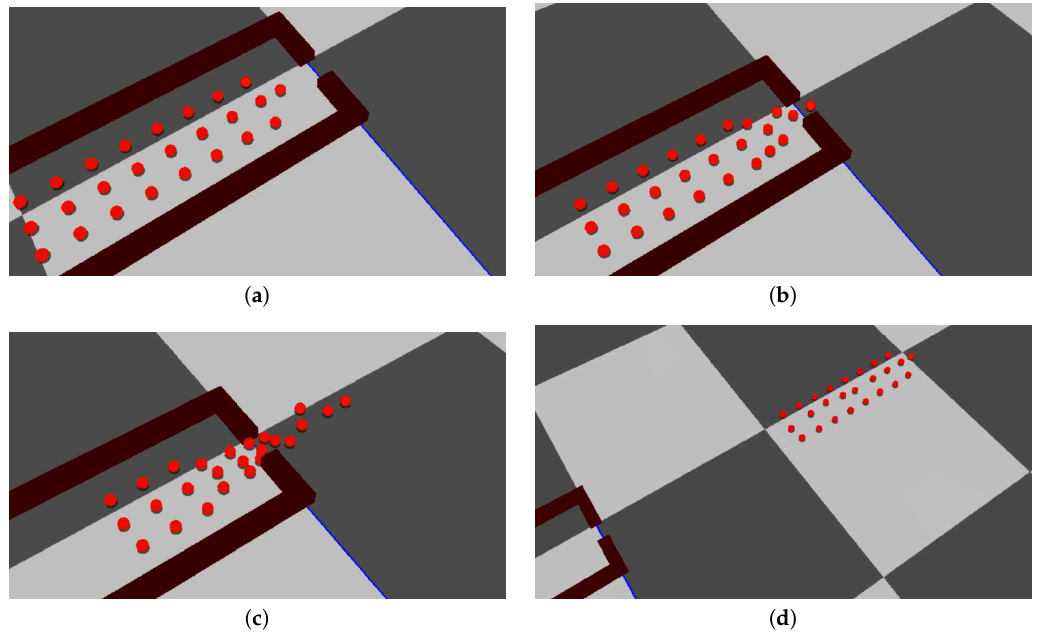
Figure 6. A demonstration of our approach in four frames. The members of a group keep their formation as much as possible: ( a ) A group of agents in a uniform formation approaching a narrow doorway. ( b , c ) Each agent, when realizes that its front path has been blocked by obstacles, will follow the selected subleader until passes that area completely ( d ) When the density of obstacles for agents is zero, they return to their previous